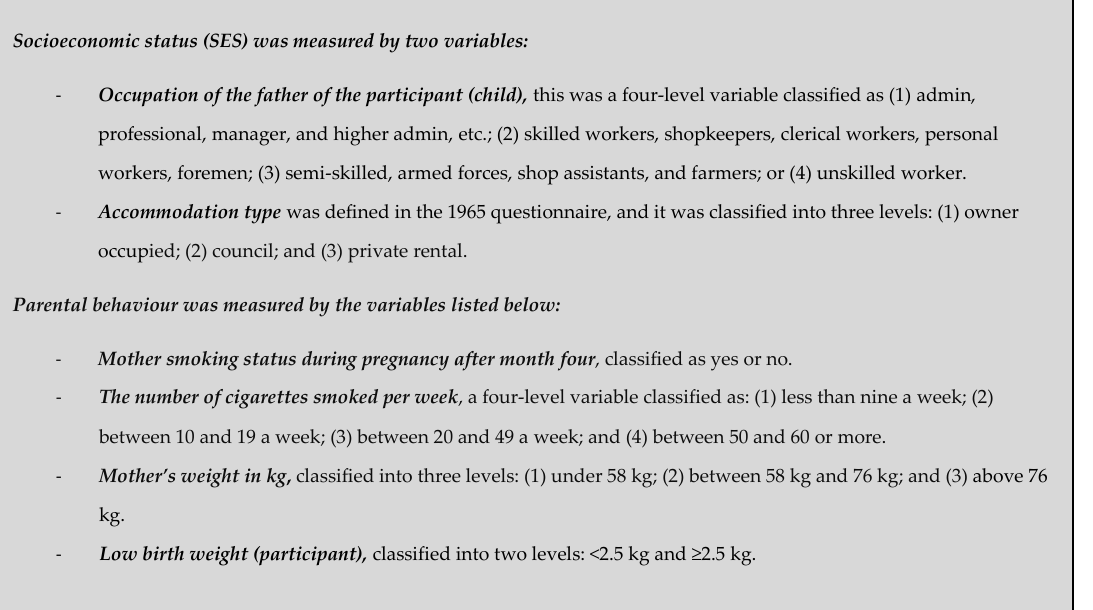
Figure 1. Brief explanation for the definitions and covariates that have been considered in the text.